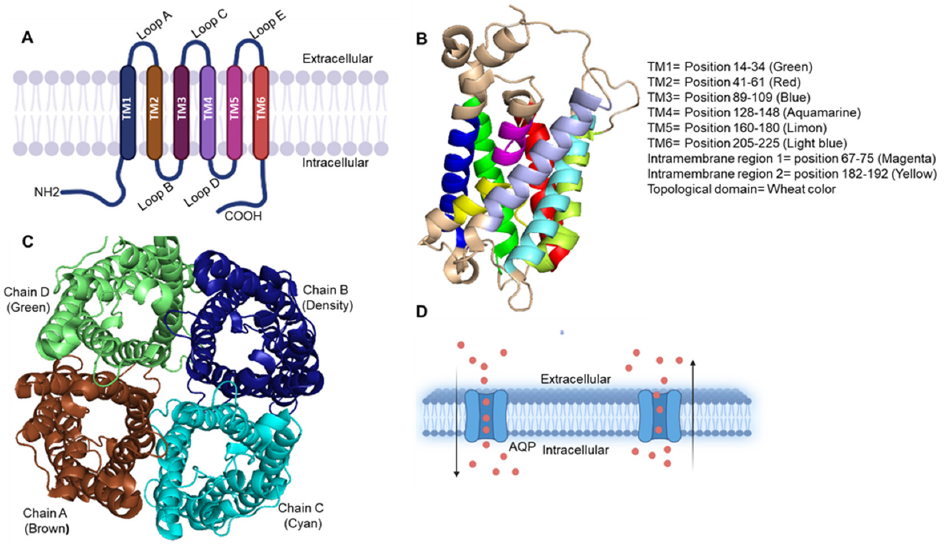
Figure 1. ( A ) Representation of three-dimensional structure of aquaporin and its topology. The illustration shows AQP protein structure, a membrane-bound protein composed of six transmembrane helices and has both the carboxyl and amino terminus regions positioned in the cytoplasm. All six transmembrane helices show connectivity with five loops named as A–E. ( B ) Monomer structure (side view) of AQP visualized by PyMOL software. It shows six transmembrane, two intramembrane and all topological domains present in the AQP with defined position and color. ( C ) Tetramer structure (top view and active form) of AQP, which is made up of four AQP monomer chains A–D (represented with different color) which in altogether forms pore in the middle for solute transfer passively. PyMOL software was used to visualize the figure. ( D ) Passive transport of water molecules through aquaporins across the membrane.